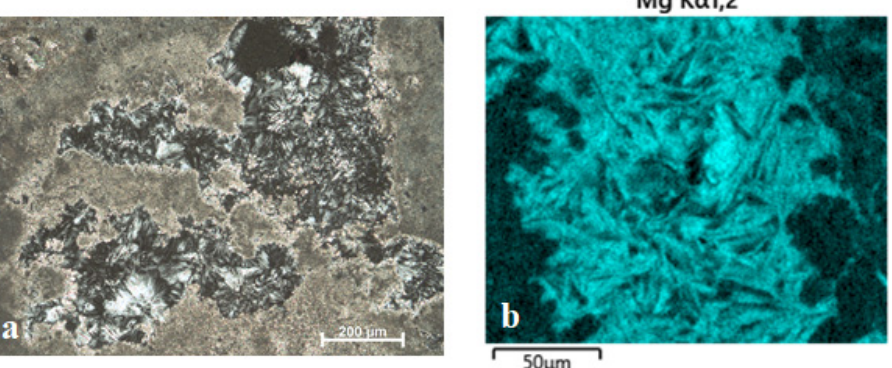
Figure 3. Microphotographs of hydromagnesite crystals in an air hardening magnesian binder of a bedding mortar belonging to a small bridge located in a rural area of the Sainte Baume massif in Provence (18th century) under ( a ) PLM, xpl, and ( b ) a particular SEM EDS map of Mg.